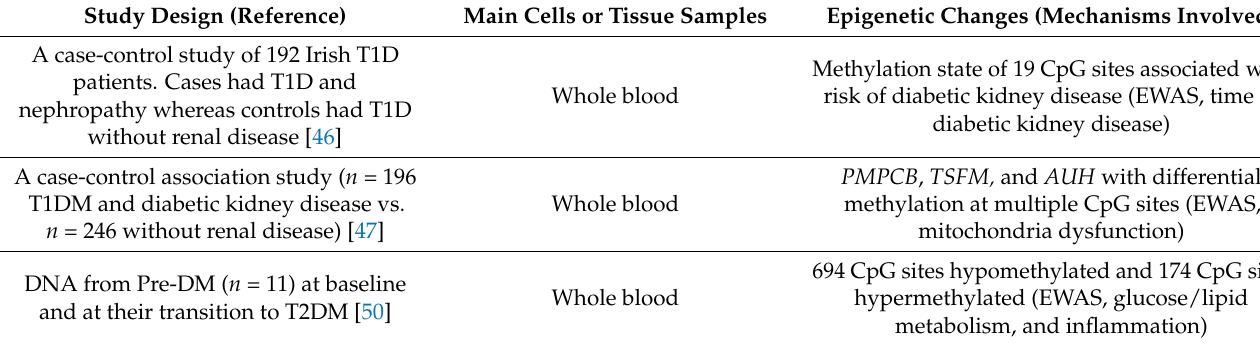
Table 1. DNA methylation in diabetic kidney